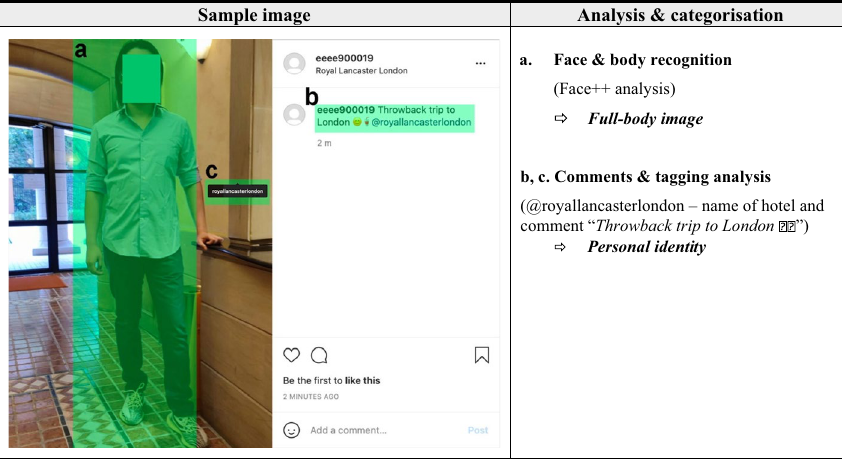
Table 2 Image analysis and categorisation (Jones,